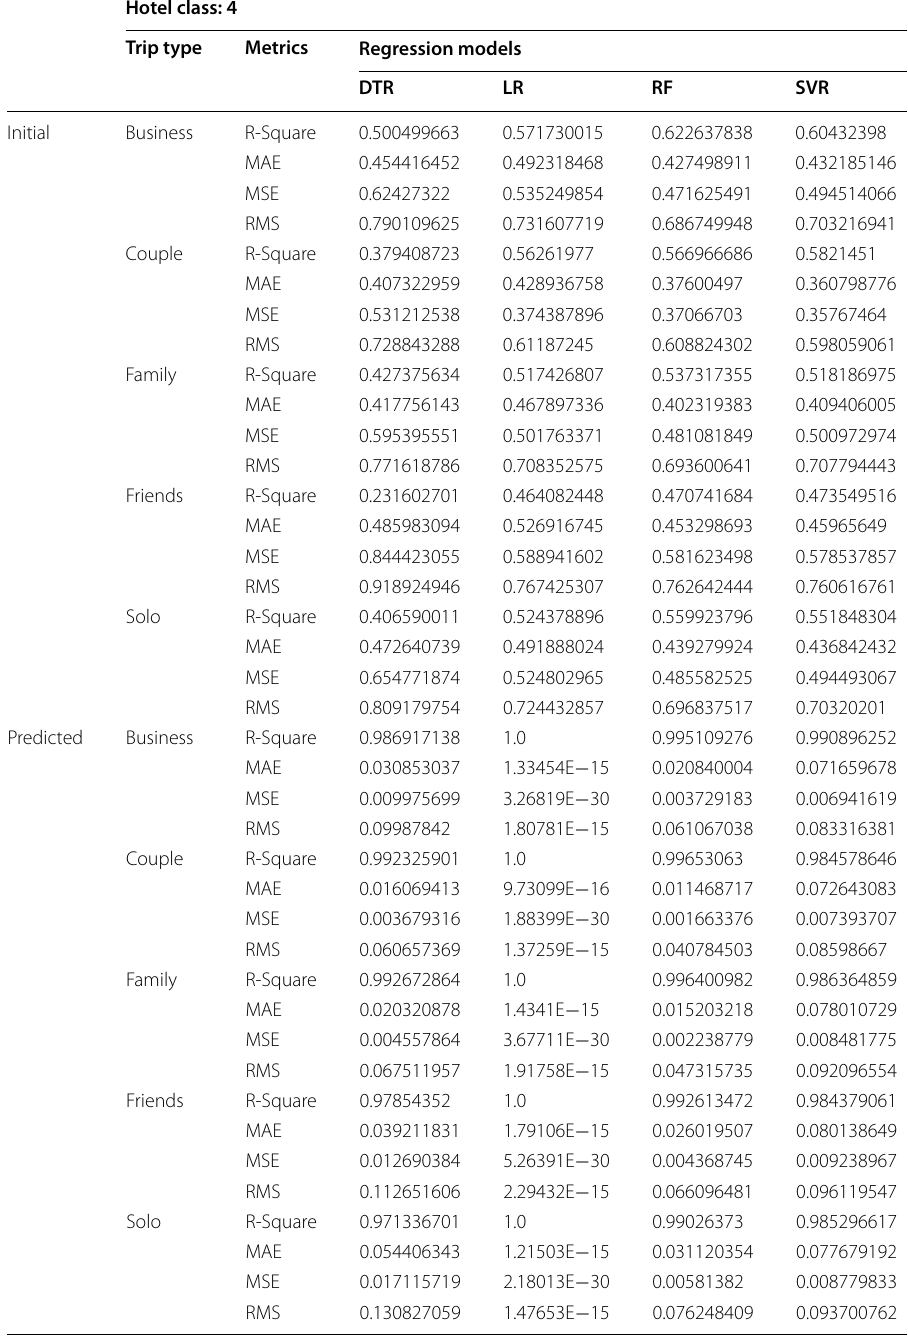
Table 4 Accuracy analysis on 4 star hotel class based on trip type (Initial and predicted